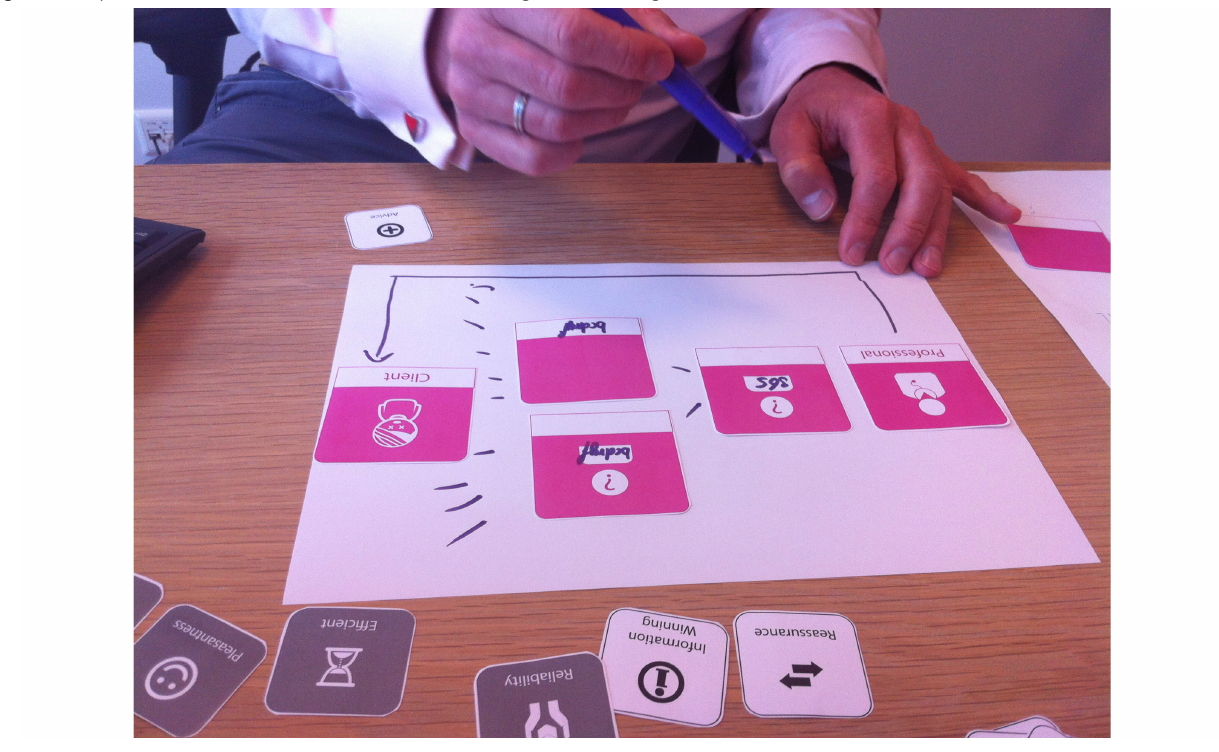
Figure 3. Impression of the use of the visual business modeling method during the interactive